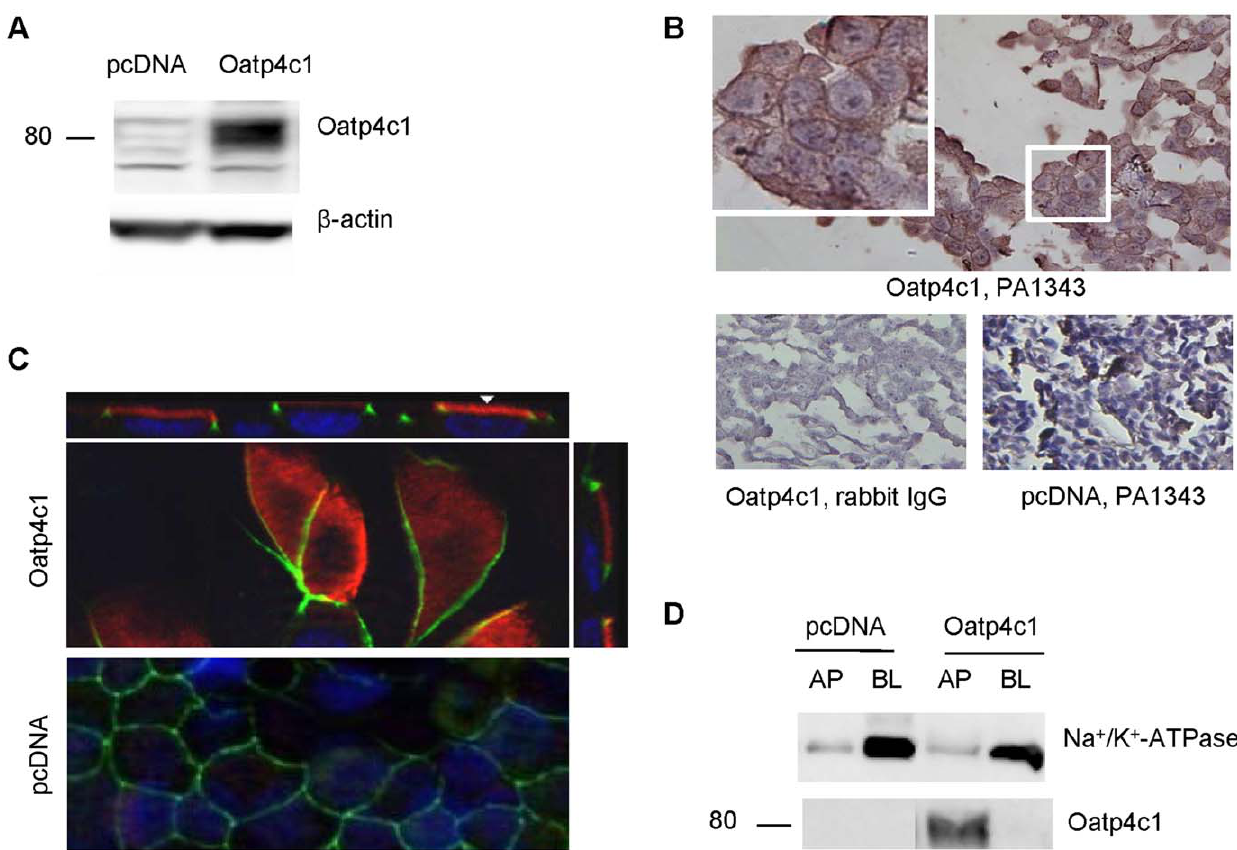
Figure 1. Validation of Oatp4c1 expression and subcellular localization in MDCKII cells. (A) Western blot analysis for Oatp4c1 expression. Protein lysates (50 m g per lane) from MDCKII cells transfected with pcDNA (empty vector) and Oatp4c1 were prepared from cells grown in monolayers. (B) Immunohistochemical analysis for Oatp4c1 expression. Paraformaldehyde-fixed paraffin-embedded cell sections were stained with PA1343. Color development with NovaRed signifies Oatp4c1 staining. All sections were counterstained with hemotoxylin. Rabbit IgG was used as a negative control. (C) Immunolocalization of Oatp4c1 in polarized MDCKII cells. Cells were double stained with Oatp4c1 (red) and ZO-1 (green). Nuclei were stained with DAPI (blue). Center image in the Oatp4c1 panel is a single optical section of the x–y plane while top and right images represent